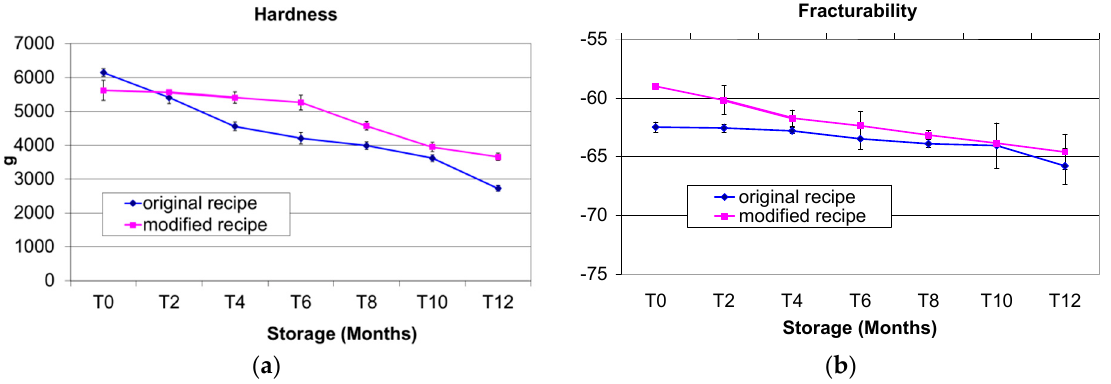
Figure 2. ( a ) Hardness of Italian Cantuccini biscuits prepared with the original recipe and the modified recipe during one year’s shelf-life. ( b ) Fracturability of Italian Cantuccini biscuits prepared with the original recipe and the modified recipe during one year’s shelf-life.